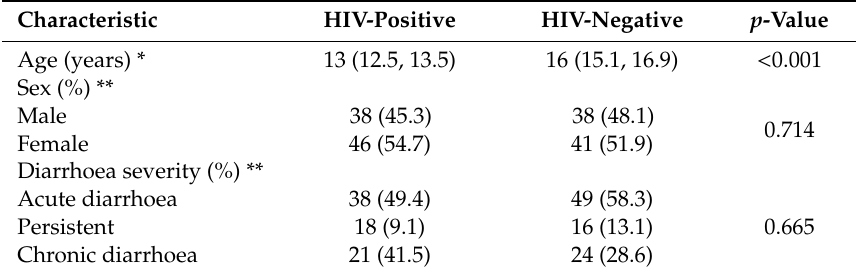
Table 1. Demographic characteristics of study